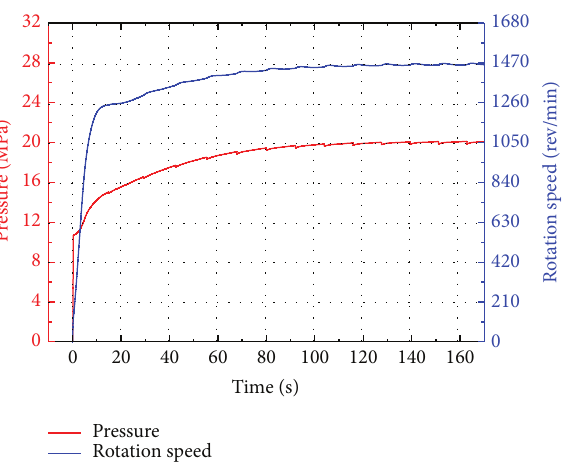
Figure 13: Power loss comparison of major components by simula-